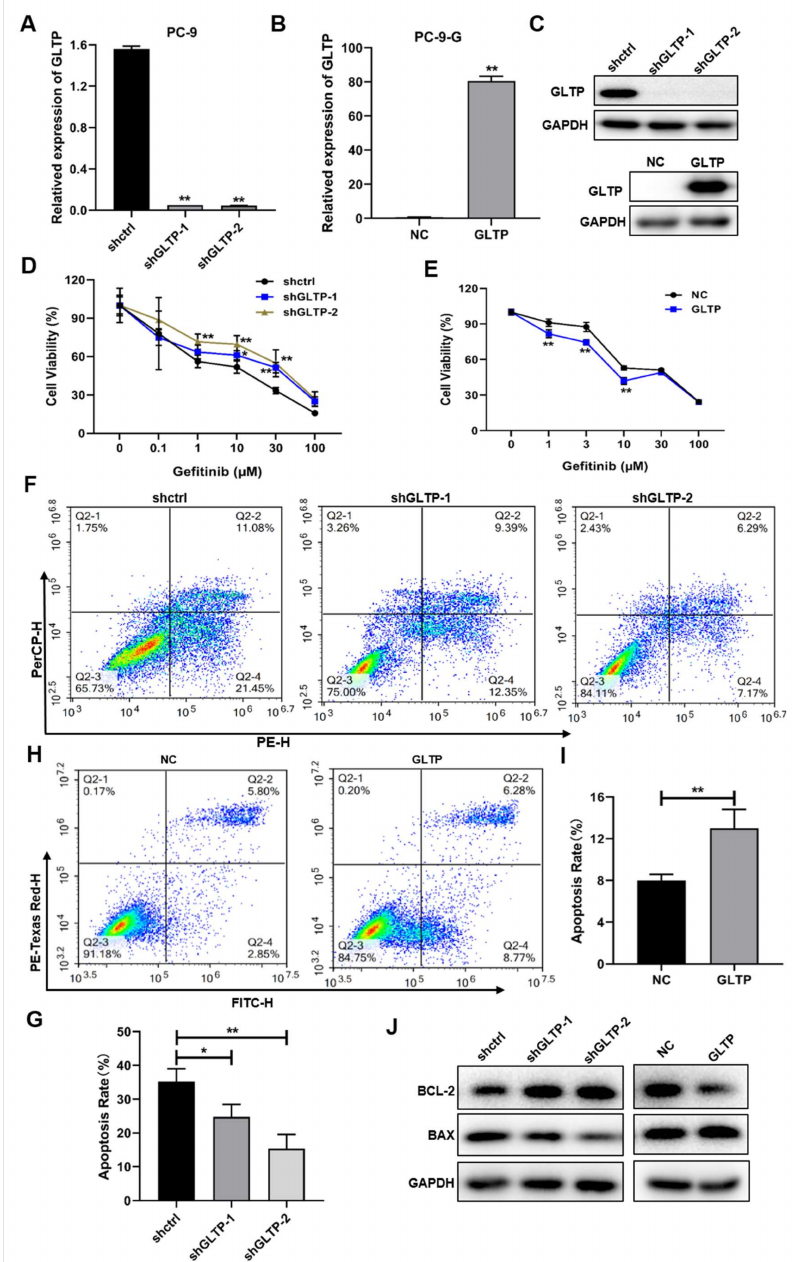
Figure 5. GLTP knockdown increased lung cancer cell resistance to gefitinib treatment through the inhibition of cell apoptosis. ( A – C ) GLTP knockdown and overexpressing stable cell lines were constructed by lentivirus infection, then selection; the expression levels of GLTP were analyzed by qRT-PCR ( A , B ) and Western blotting ( C ). ( D , E ) The cell viabilities were analyzed in cells with GLTP knockdown ( D ) or overexpression ( E ) and treated with different concentrations of gefitinib for 48 h using CCK8 assay. ( F ) Flow cytometry was used to measure cell apoptosis in GLTP knockdown cells after gefitinib (PC-9, 1 µ M) treatment for 48 h. ( G ) Apoptosis rates of cells as in ( F ) were illustrated by histogram. ( H ) GLTP overexpression cells were treated with gefitinib (PC-9-G, 5 µ M) for 48 h; then, the proportion of cell apoptosis were measured by flow cytometry. ( I ) Cell apoptosis rates were quantitatively calculated from three independent experiments. ( J ) The protein expression levels of BCL-2 and BAX were detected by Western blotting in cells with GLTP knockdown or overexpression. Data represent the mean ± S.D. of 3 independent experiments where * indicates significant difference at p < 0.05, ** at p <